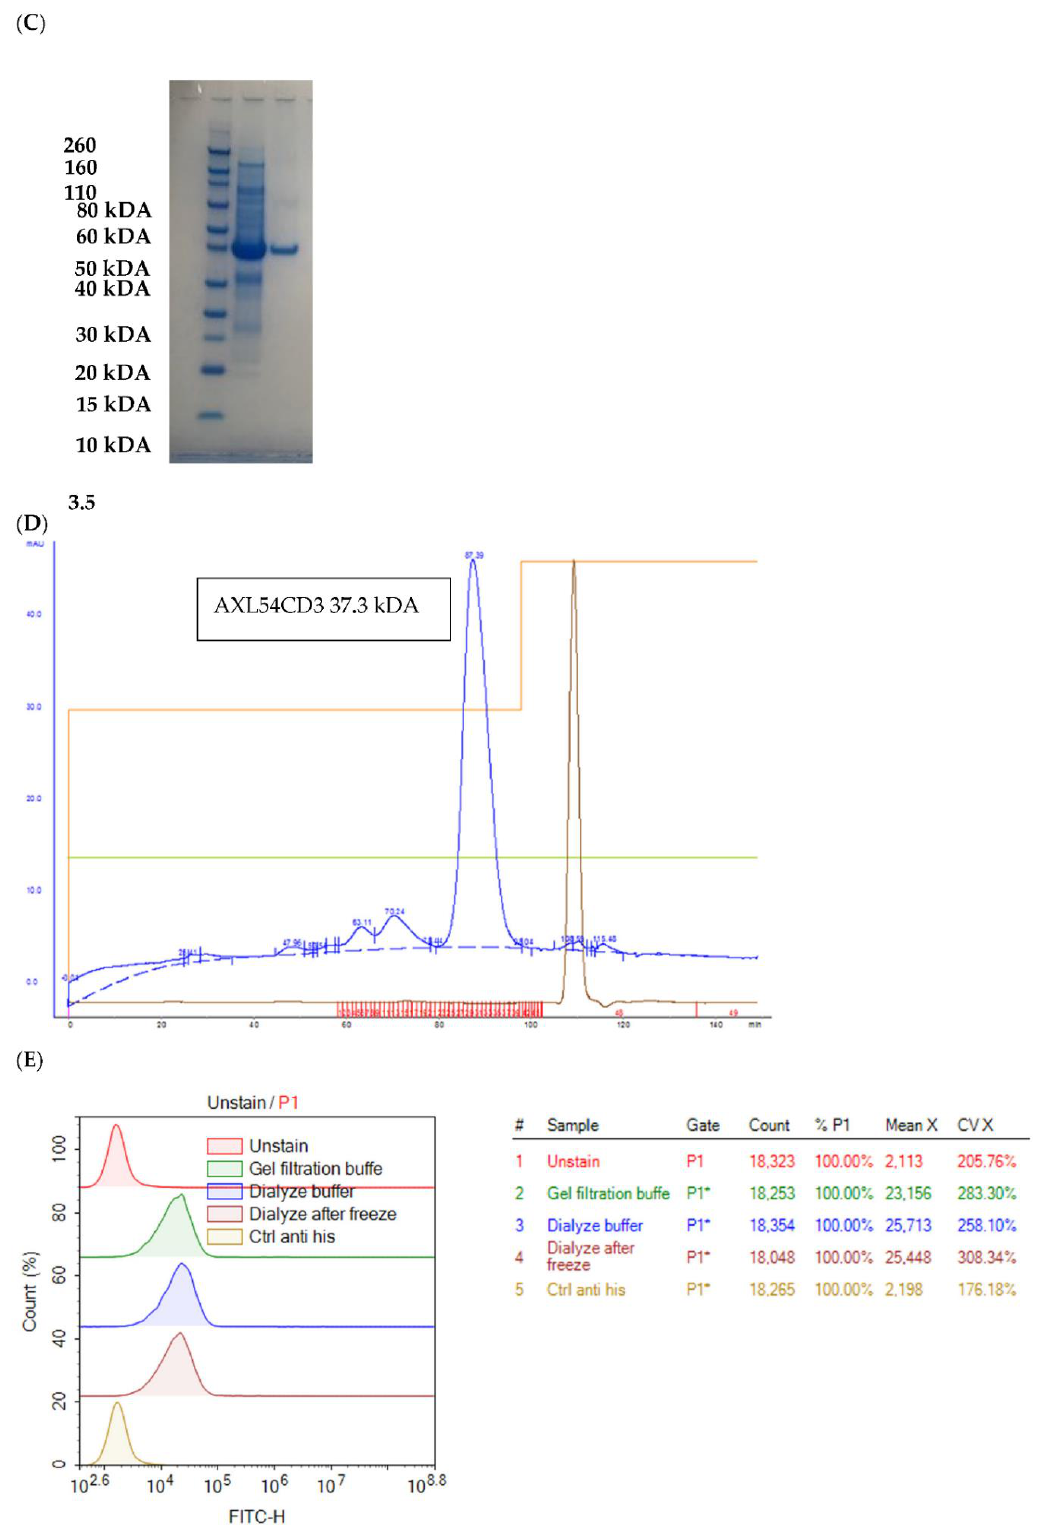
Figure 8. ( A ) Design of the Bispecific AXL54CD3 protein ( B ) AXL54CD3 mode of action ( C ) The reduced SDS-PAGE gel of the purified 37.3 kDa AXL54CD3 protein. Lane 2 is the protein after HIS-tag purification and Lane 3 is after a second size exclusion chromatography step. ( D ) The SEC trace (blue) of AXL54CD3 purified over a HiLoad 16/60 Superdex-200 prep-grade column. ( E ) The functional activity of the protein is tested by FACS on MDA-MB-231 cells after the SEC (green), after dialysis into storage buffer (blue), and after a freeze thaw (brown). Activity remains the